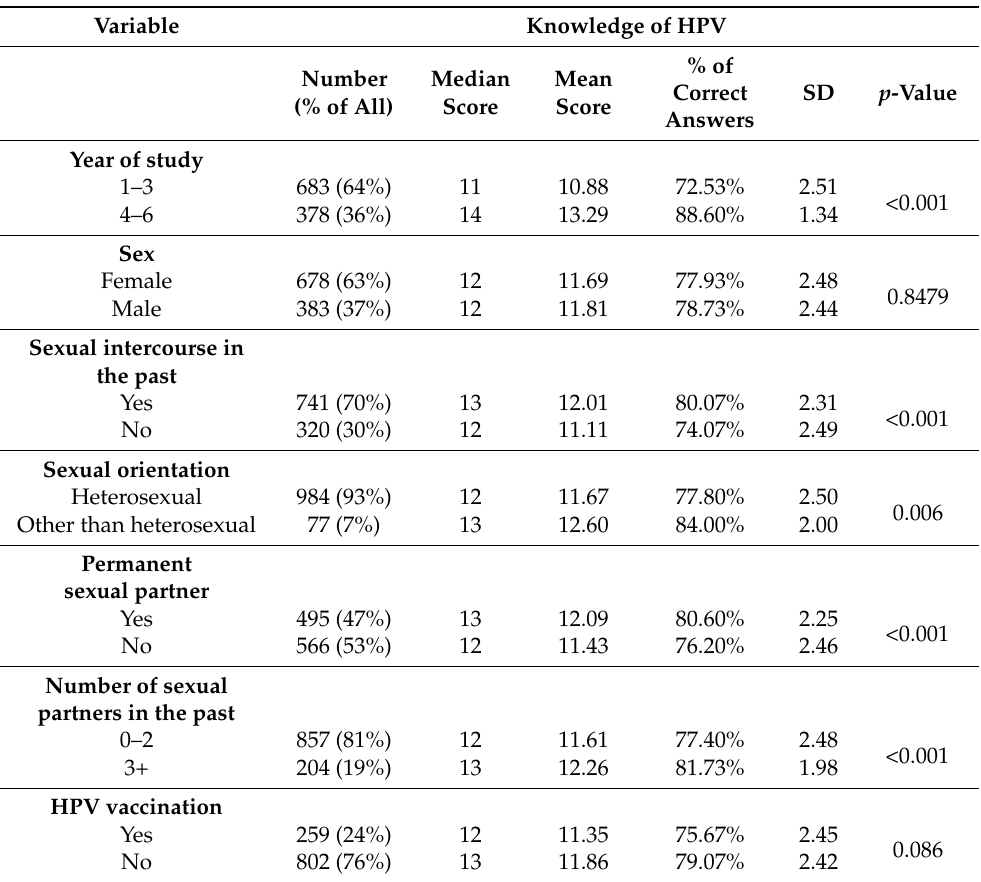
Table 1. Characteristics and personal sexual history of participants in the study and their association with HPV knowledge. Variable Knowledge of